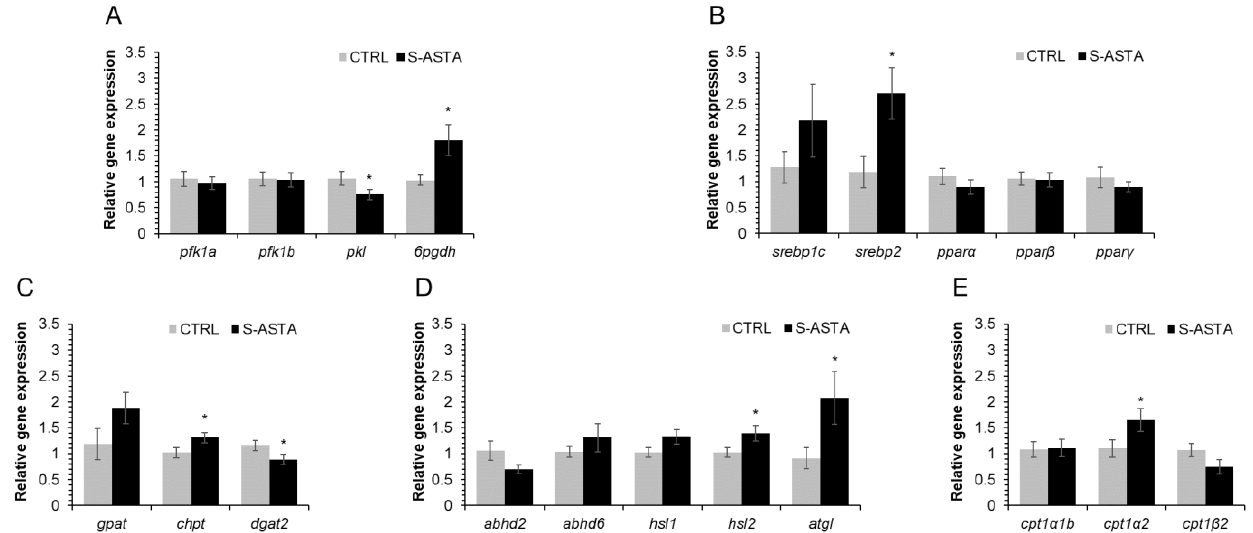
Figure 3. Hepatic expression of genes involved in glycolysis ( pfk1a , pfk1b and pkl ) and the oxidative phase of the pentose phosphate pathway ( 6gdph , ( A )), transcription factors regulating lipogenesis ( srebp1c , srebp2 , pparγ ), lipolysis and β -oxidation ( pparα and pparβ , ( B )), PL and TAG synthesis ( C ), lipolysis ( D ) and β -oxidation ( E ) in rainbow trout fed a diet without (CTRL) or with astaxanthin (S- ASTA) for 12 weeks. Values are expressed as mean ± SEM ( n = 9 fish). * p < 0.05 according to t -test